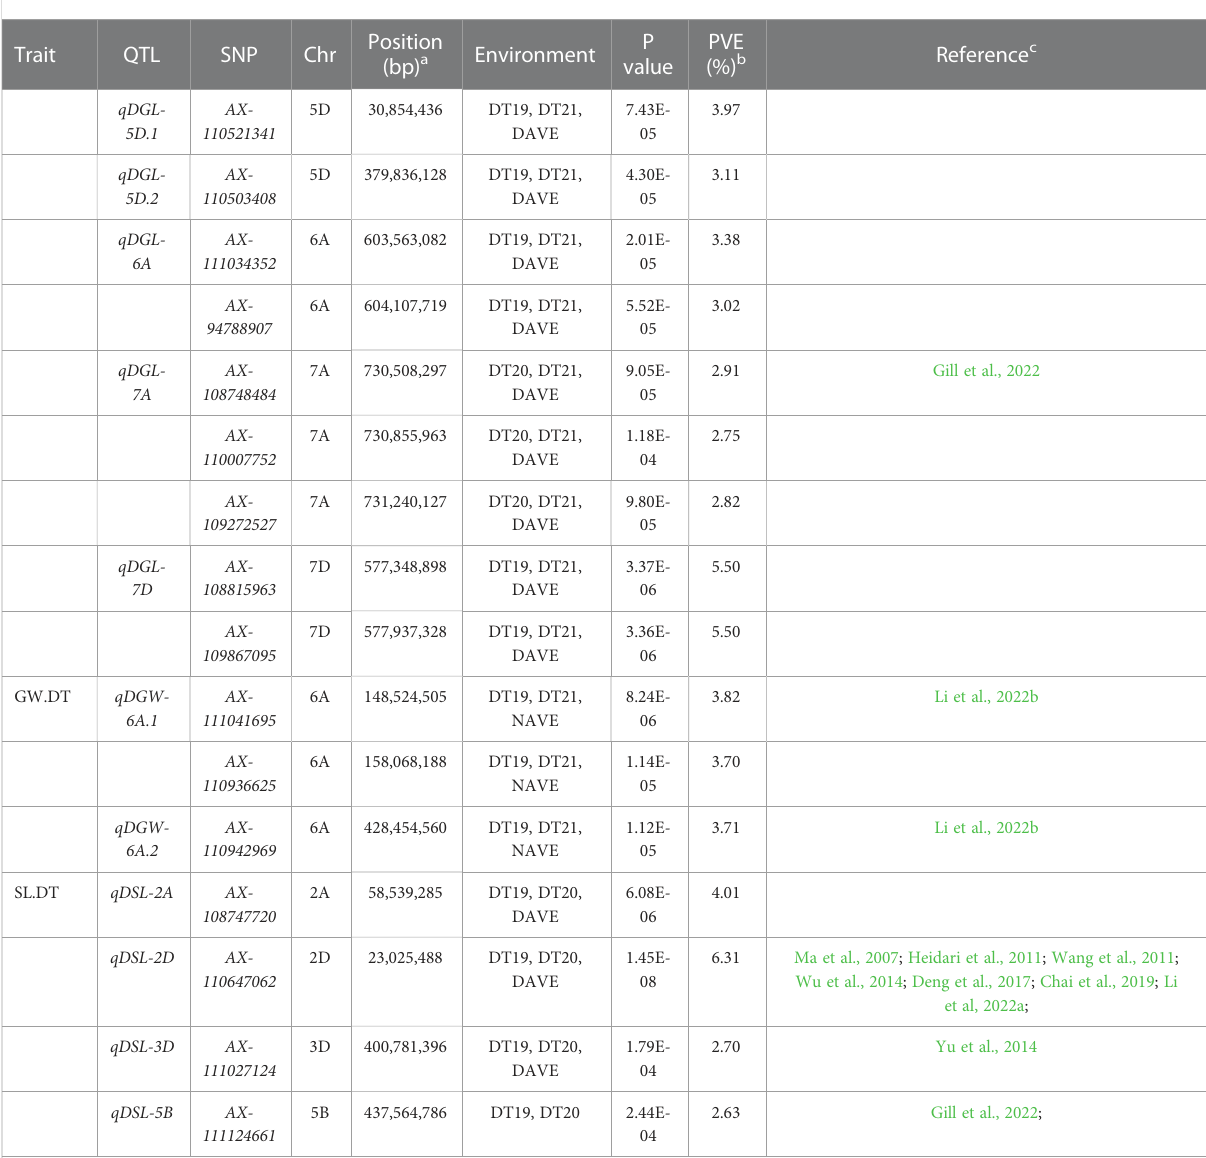
2.92% of the phenotypic variation (Figure 5A,